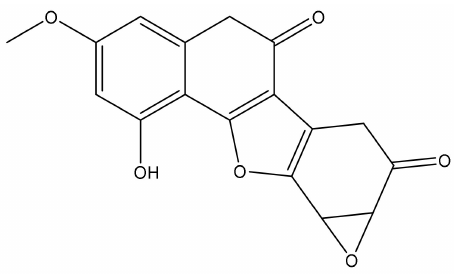
Figure 1. Structure of